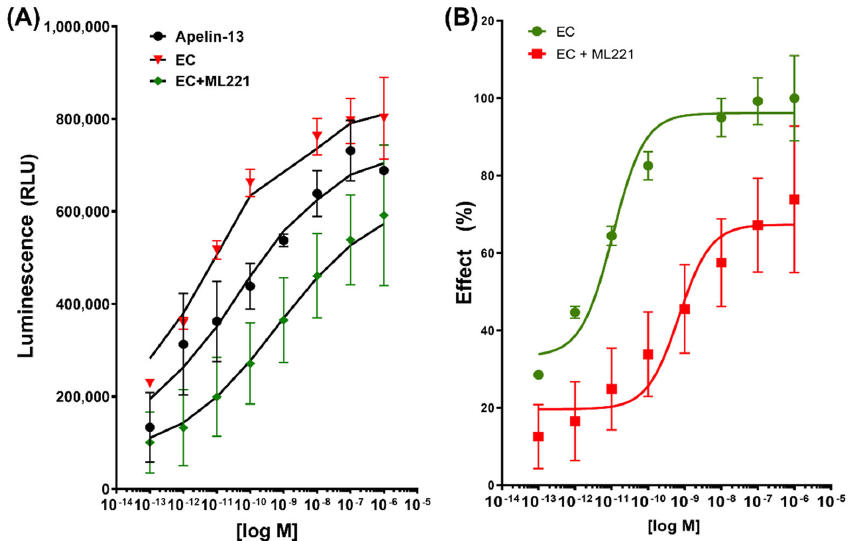
Figure 2. ( A ): Nonlinear regression with the specific binding with hillslope model for apelin-13, (-)-epicatechin (EC), and the mixture with its antagonist ML221. Relative luminescence units (RLU) are plotted on the y -axis, and data are expressed as mean S.E.; ( B ) dose–response curve of normalized data taking the EC effect as 10%.